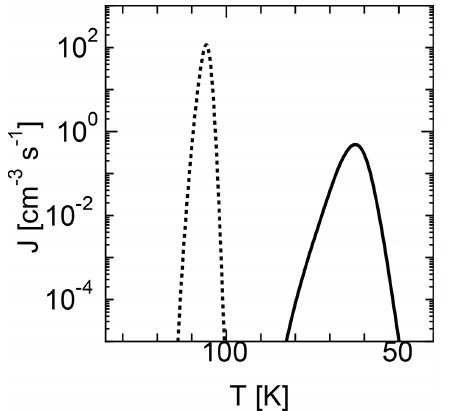
Figure 3. Time evolution of the nucleation rates of two models us- ing homogeneous nucleation. The solid curve shows the results of the SP model, while the dotted curve shows the results of the MCNT model.